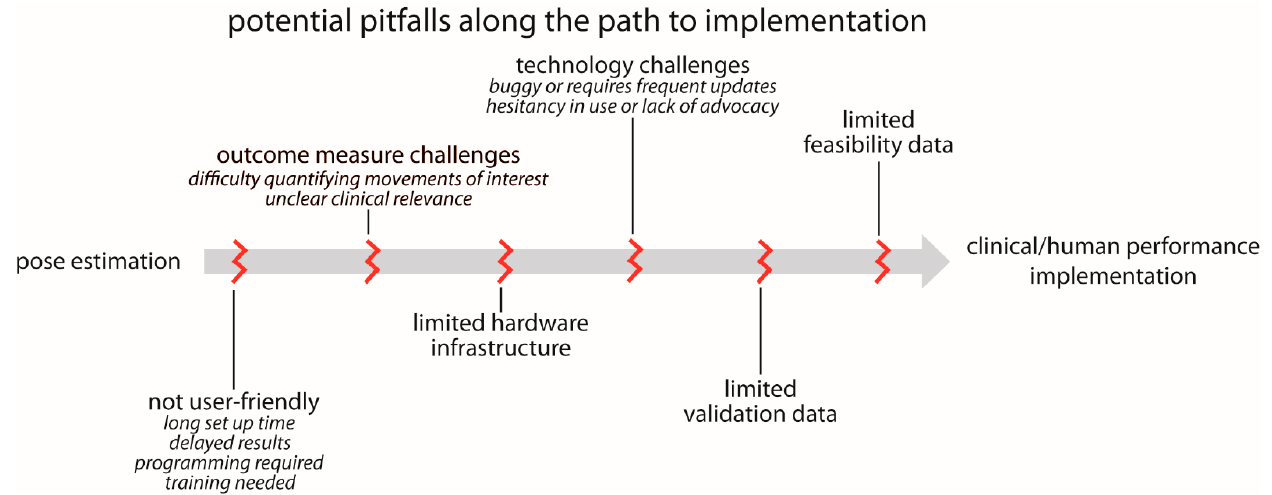
Figure 6. Common pitfalls that must be avoided on the path to widespread implementation of pose estimation applications for human health and performance. These are covered in greater detail in the “ What are limitations of pose estimation? ” section of the manuscript.